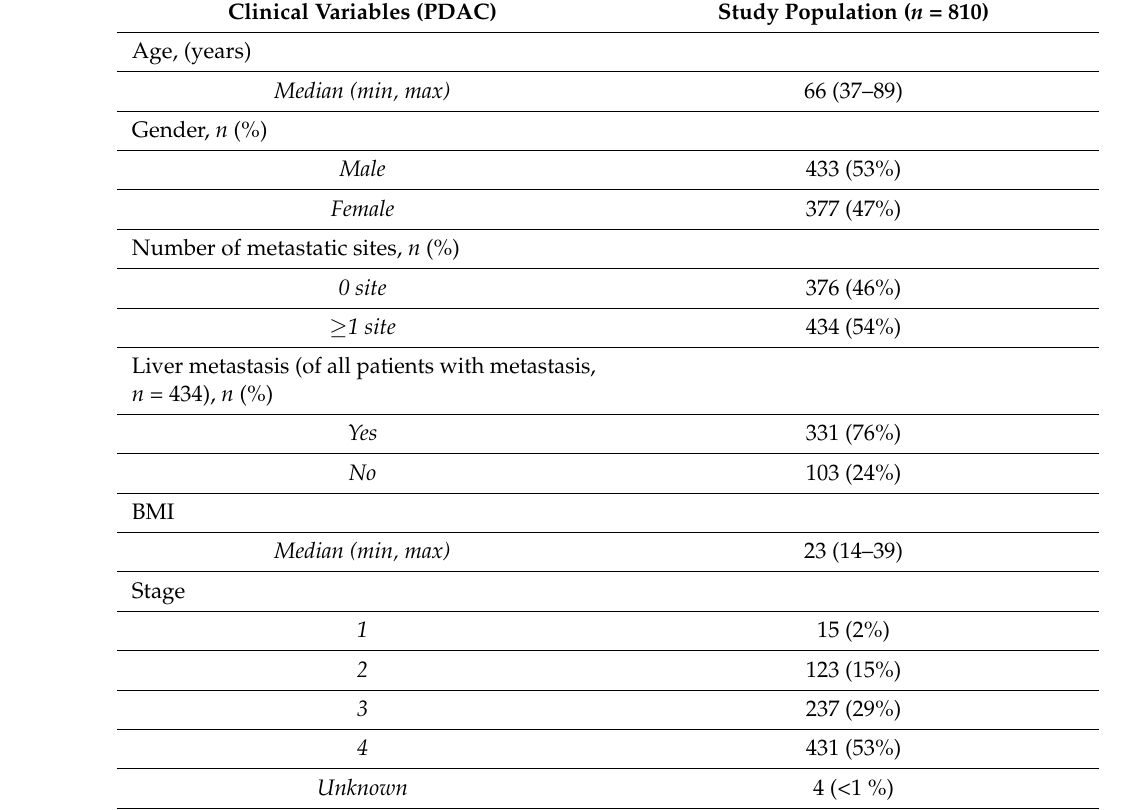
Table 1. Patient